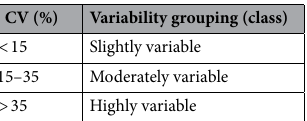
Table 2. Grouping coefficient of variation into variability classes.